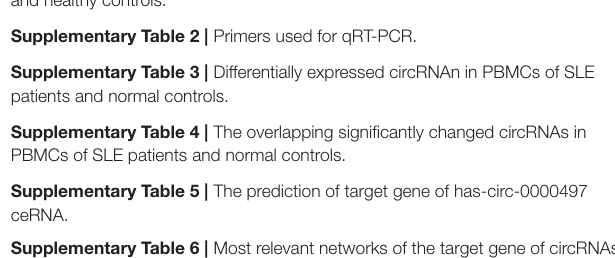
Supplementary Figure 1 | Data analysis overview. Differentially expressed circRNAs (fold change > 2 and P < 0.05). The intersection of these differentially expressed circRNAs among the SLE-stable, SLE-active, and HC groups was analyzed to narrow dysregulated circRNAs down to 15 upregulated circRNAs. Candidate circRNAs were then validated using qPCR in three cohorts. Finally, the association between candidate circRNAs in PBMCs and clinical characteristics of SLE patients were analyzed. Supplementary Figure 2 | The top-scoring (by the number of pathways) AN network from hsa_circ_0000479_target genes. Thick pink lines indicate fragments of WNT-related signaling pathways. Upregulated genes are marked with red circles; downregulated with blue circles. The red arrow indicates the hsa_circ_0000479 target gene WNT-16 . Supplementary Table 1 | Clinical characteristics of SLE patients, RA patients, and healthy controls. Supplementary Table 2 | Primers used for qRT-PCR.